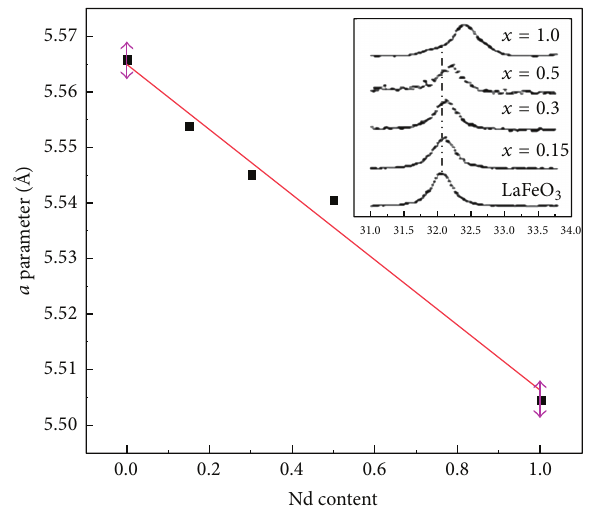
Figure 2: a -Cell parameter versus Nd content.